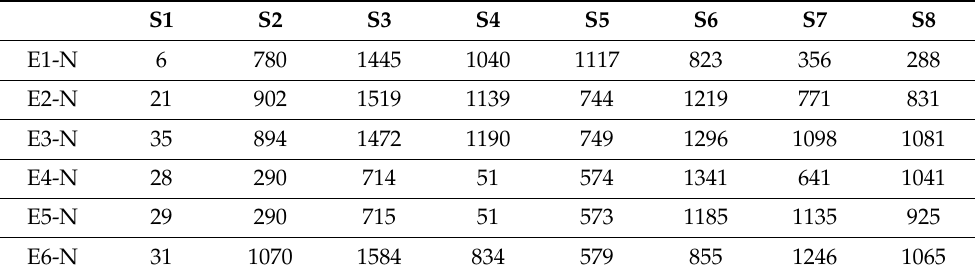
Table 3. The water age (day) of the sites 1–8 (S1, S2, S3, S4, S5, S6, S7, and S8 in Figure 2) after 5 years’ simulation for the six scenarios without farmland drainages (E1-N, E2-N, E3-N, E4-N, E5-N, and E6-N). S1